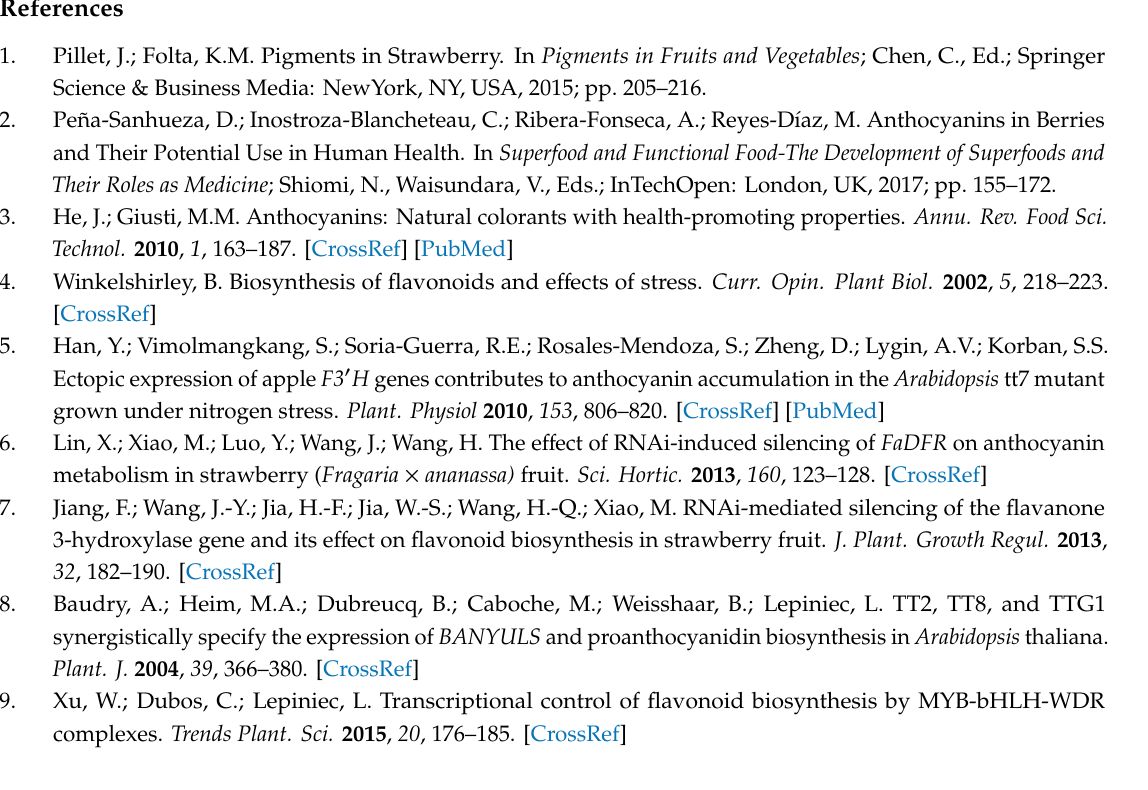
Table S1. The basic information of FaGST genes in cultivated strawberry. Table S2. The coe ffi cient value and p -value of correlation analysis. Table S3. Cis-regulatory elements identified in the putative anthocyanins-related FaGST genes. Table S4. Lists of all primers used for qPCR analysis in this study. Figure S1. Chrome distribution of FaGST genes in the cultivated strawberry